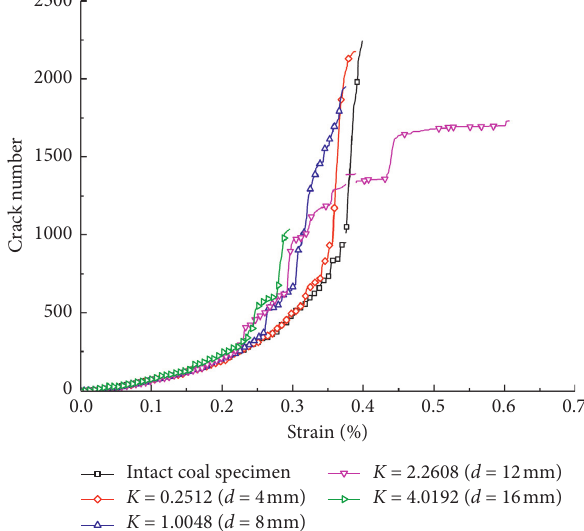
Figure 7: Curve of crack number and strain.